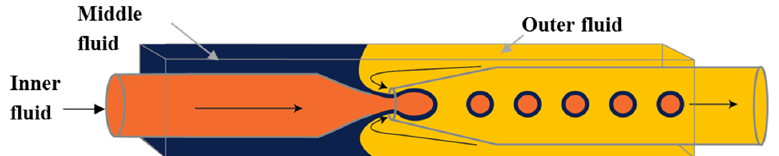
Figure 13. Schematic illustration of coaxial microcapillary fluidic device for making double emulsions in a single step. The geometry requires the outer fluid to be immiscible with the middle fluid and the middle fluid to be in turn immiscible with the inner fluid [14].